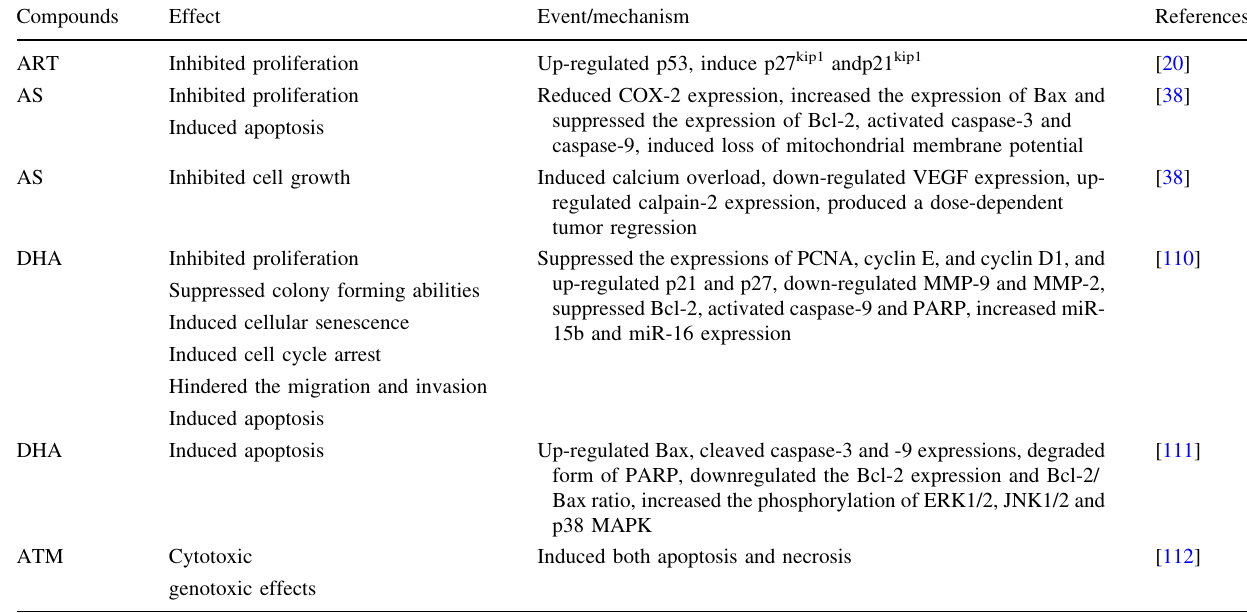
Table 7 Anti-gastric cancer cells activities of artemisinins